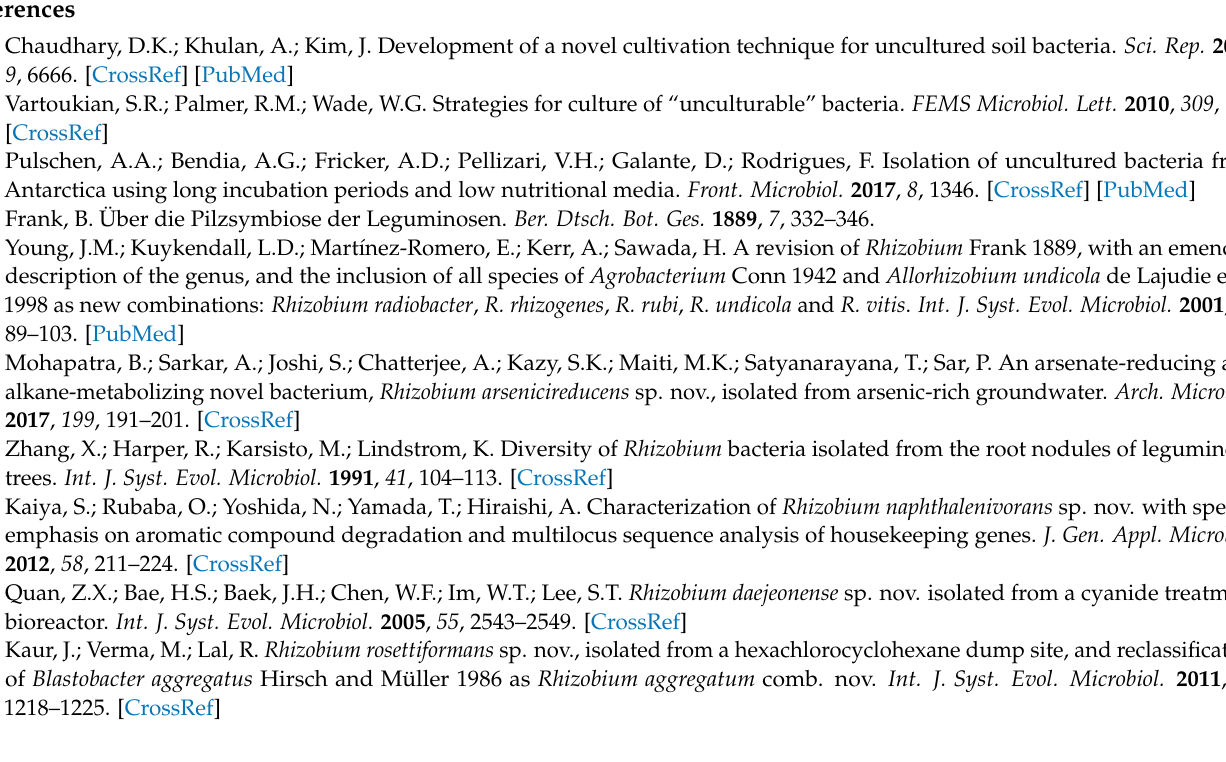
agar. Table S1: The distribution of biosynthetic gene clusters in strain S-51 T ; Table S2. N 2 -fixation regulatory proteins in S-51 T